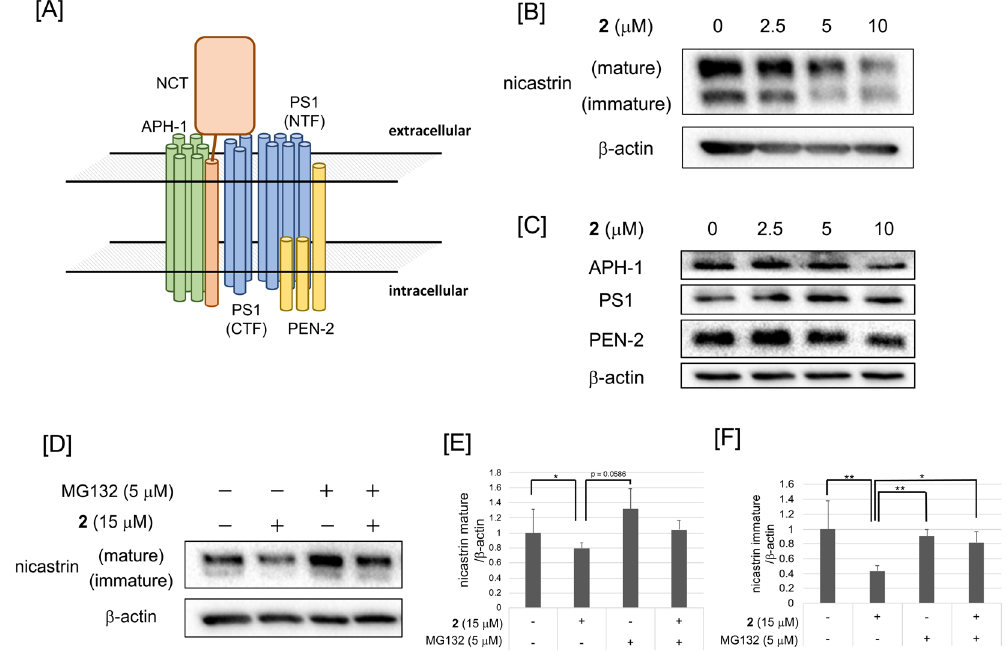
Figure 8. Inhibition of expression of components of the γ -secretase complex by cowanin ( 2 ) in HPB-ALL cells. ( A ) Schematic representation of γ -secretase complex. γ -Secretase is composed of four membrane proteins: presenilin1 (PS1), nicastrin (NCT), anterior pharynx defective 1 (APH-1) and presenilin enhancer 2 (PEN-2). ( B , C ) Western blot analysis of nicastrin, APH-1, PS1 and PEN-2 expression in HPB-ALL cells after treatment with cowanin ( 2 ). HPB-ALL cells (1 × 10 6 cells/dish) were incubated in a 6-cm dish for 72 h at 37 °C with 2 . The effect on protein expression was analyzed by Western blotting. β -Actin was used as internal control. ( D ) MG132 abrogated the reduction of nicastrin expression by cowanin ( 2 ). HPB-ALL cells (1 × 10 6 cells/dish) were incubated in a 6-cm dish for 12 h at 37 °C with 2 . The effect on protein expression was analyzed by Western blotting. β -Actin was used as internal control. ( E , F ) Relative protein levels of nicastrin mature and immature analyzed by densitometry. Data are presented as the mean with SD from three independent experiments. * P < 0.05 and ** P < 0.01 are considered statistically significant. P values were analyzed by Student’s t